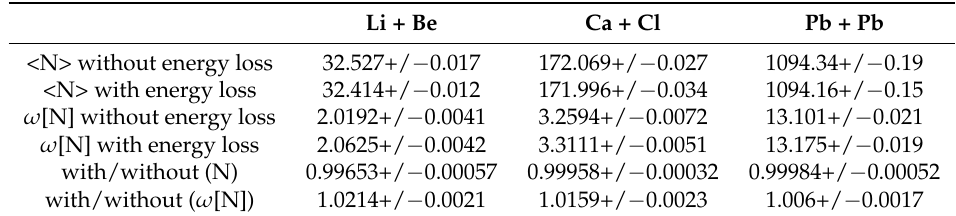
Figure 8. Energy distributions of forward spectators with realistic energy leakage from the calorimeter in WNM. Table 1. Comparison of results for 10% most central events with realistic energy leakage and without it in a frame of